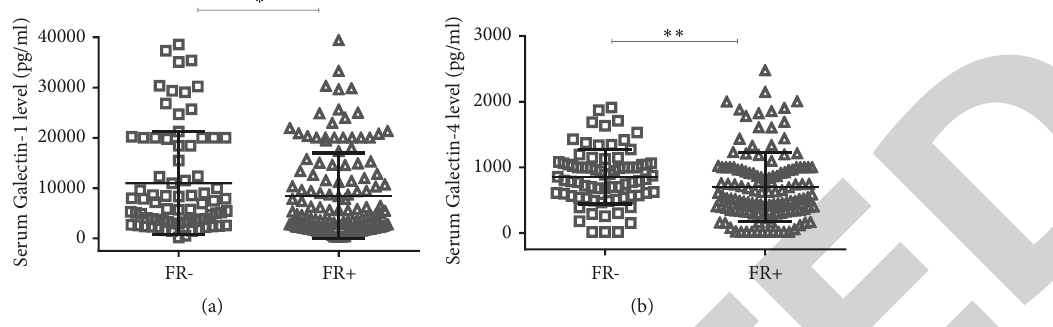
Figure 4: (a) Evaluation of rheumatoid factor and levels of Galectin-1. (b) Evaluation of rheumatoid factor and levels of galectin-4.